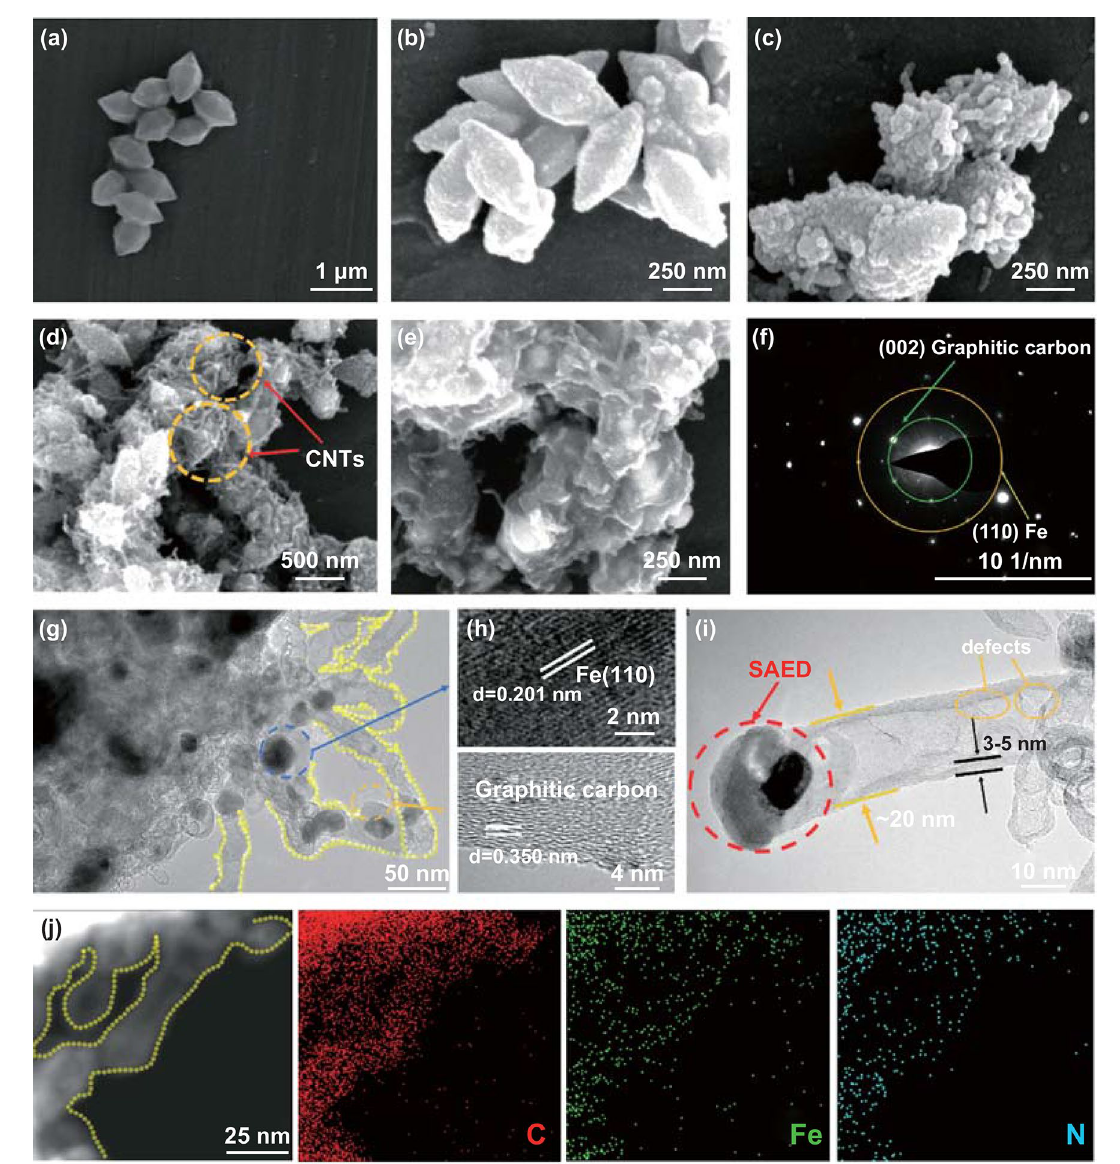
Fig. 2 SEM images of a MIL-88B-NH 2 , b MIL-Fe-800, c MIL/CNT–Fe-700, d MIL/CNT–Fe-800, and e MIL/CNT–Fe-900. f SAED patterns for MIL/CNT–Fe-800 (marked in i by red circle and stated by “SAED”). g TEM images of MIL/CNT–Fe-800. h HRTEM images of MIL/CNT– Fe-800. i TEM image of single CNT–Fe structure for MIL/CNT–Fe-800. j EDX mapping of